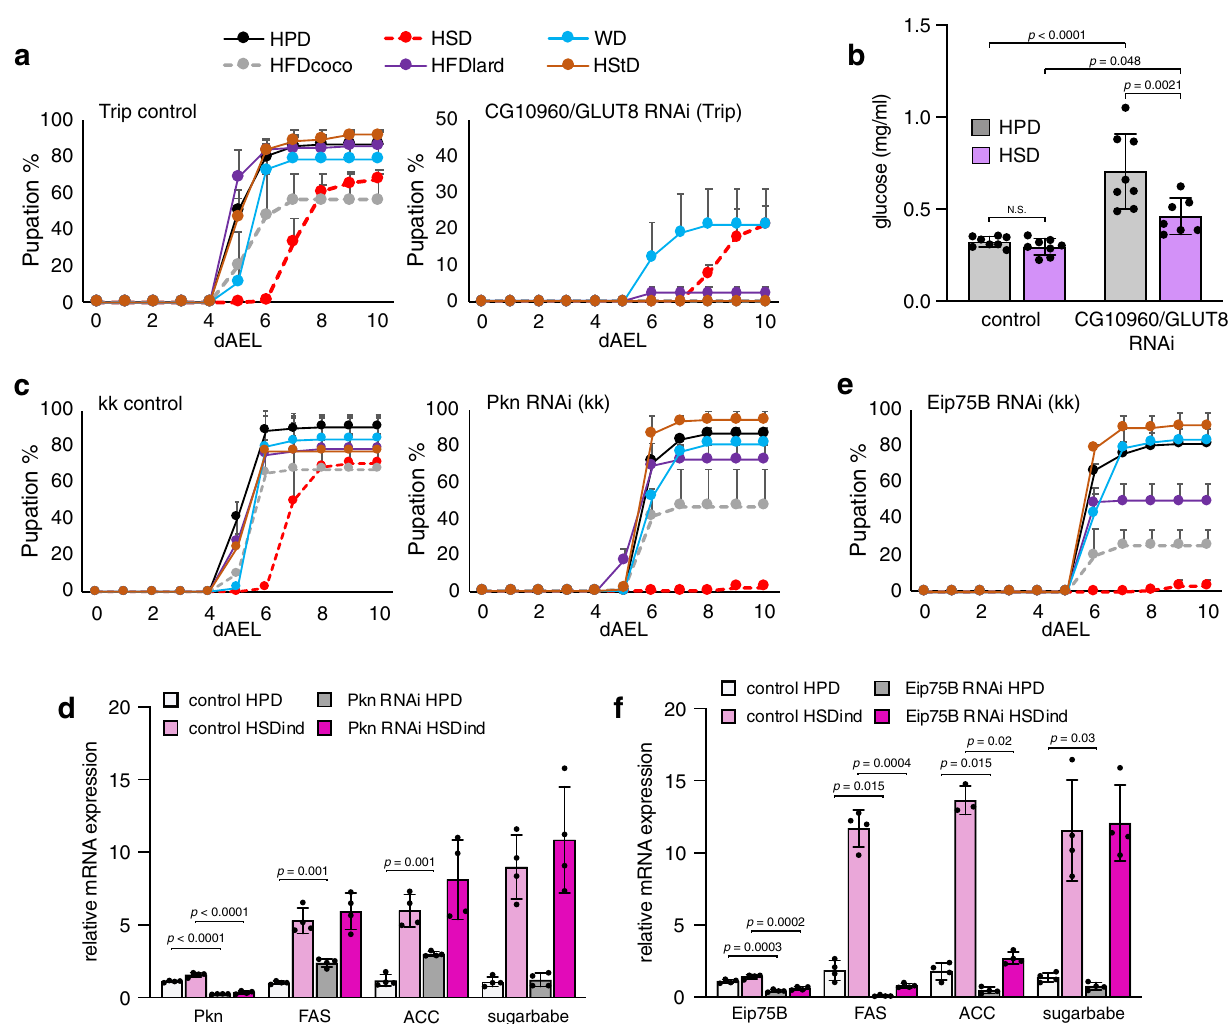
Fig. 5 CG10960/GLUT8, Pkn, and Eip75B regulate sugar tolerance in Drosophila . a Pupation kinetics of CG10960/GLUT8 RNAi and Trip control ( Tub- GAL4 > ) animals on six different diets, n = minimum of 3 vials (each with 30 larvae) per diet and genotype. b Circulating glucose levels of CG10960/GLUT8 RNAi and Trip control ( Ubi-GAL4 > ) larvae on HPD and HSD (10% sucrose), n = minimum of 7 (each with 15 larvae) per diet and genotype. c Pupation kinetics of Pkn RNAi and kk control ( Tub-GAL4 > ) animals on six different diets, n = 3 vials (each with 30 larvae) per diet and genotype. d Whole-body expression of Pkn , FAS , ACC, and sugarbabe in control and Pkn RNAi ( Tub-GAL4 >) larvae after transient (8 h) HSD feeding (HSDind), n = 4 ( fi ve